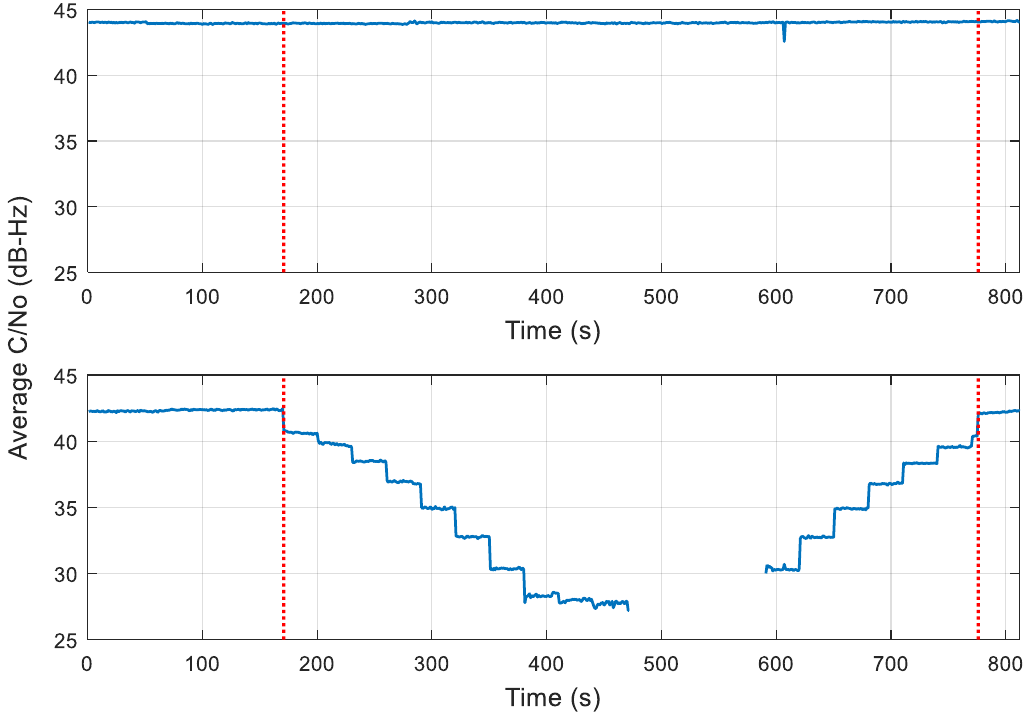
Figure 10. Averagecarrier-to-noiseratioofscenario#3. ( Topfigure )—GPSmeasurements; ( bottomfigure )— Figure 10. Average carrier-to-noise ratio of scenario #3. ( Top figure )—GPS measurements; ( bottom GLONASS figure )—GLONASS measurements.